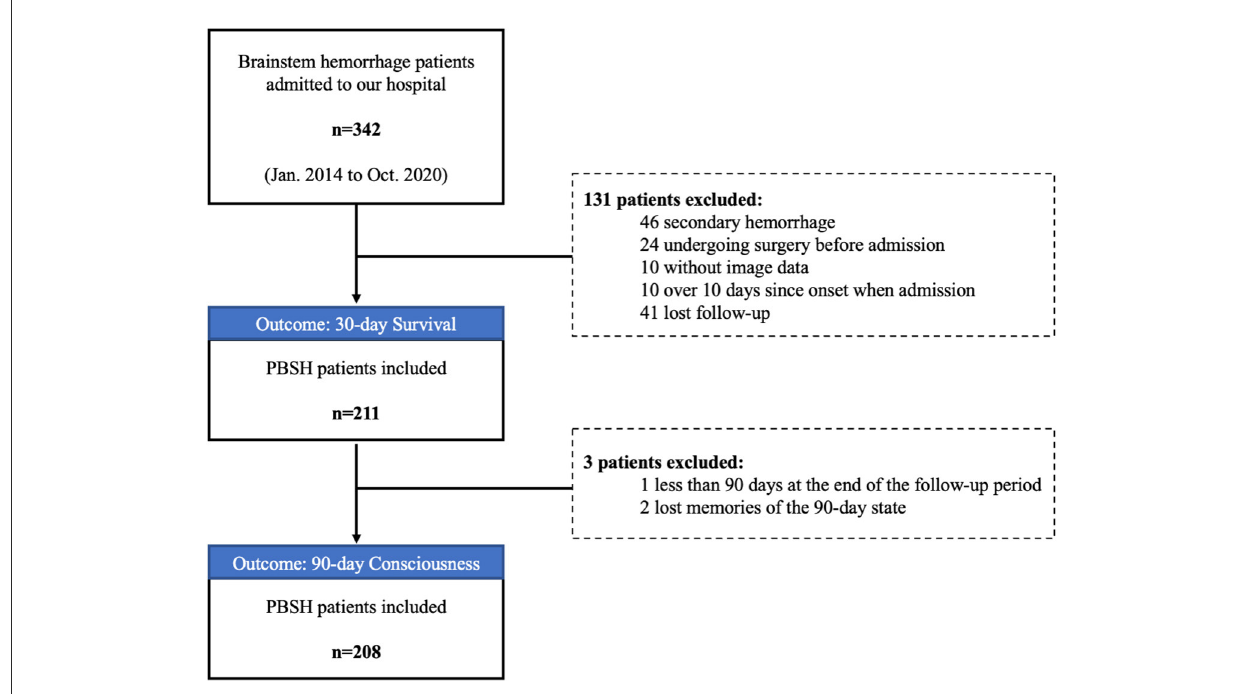
FIGURE2 Flow chart of patient